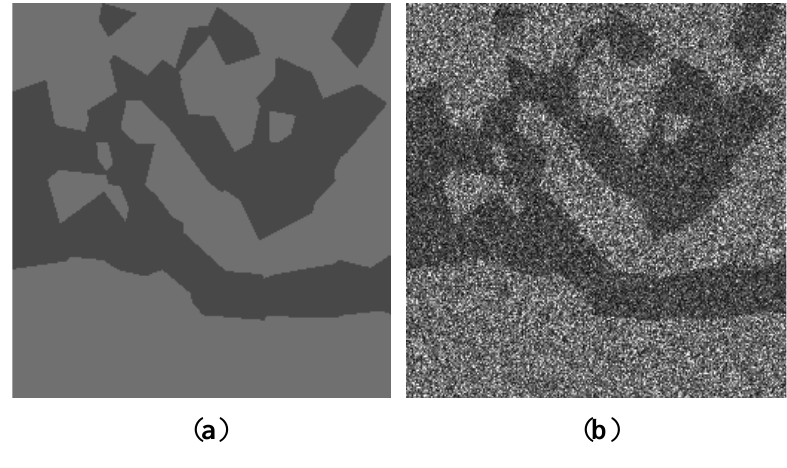
Figure 2. Results of ( a ) the partition of domain; ( b ) the simulated SAR image.